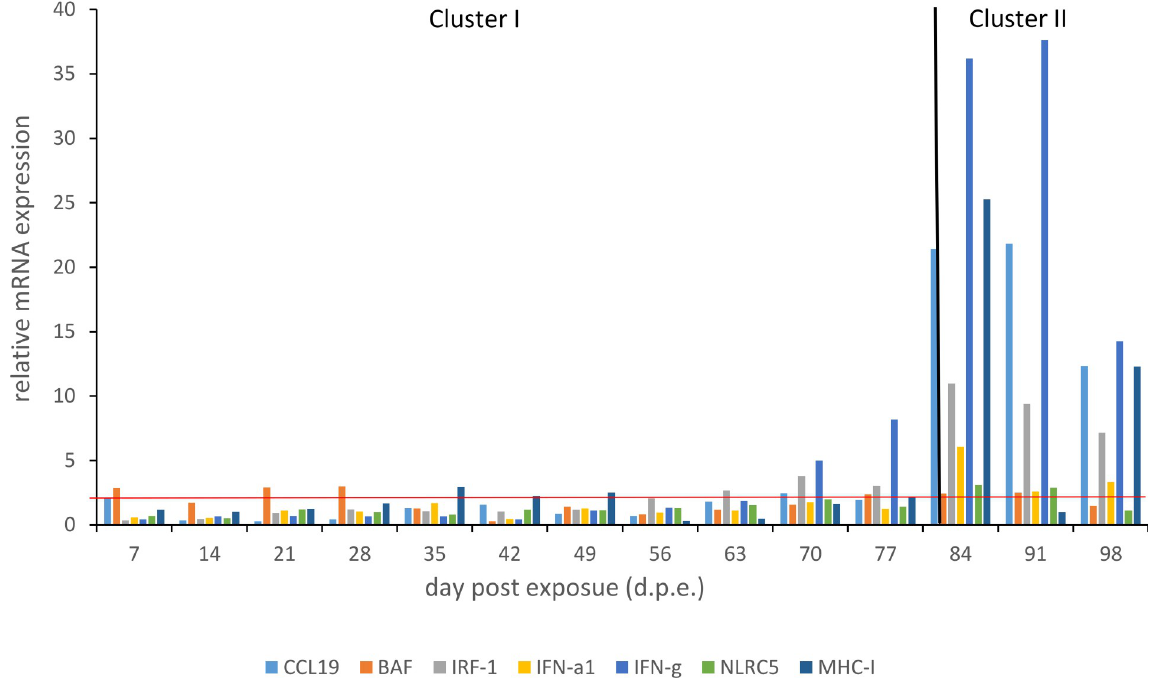
Fig 4. Gene expression profiles over experimental time course (7 to 98 d.p.e.) of genes involved in immune response: Barrier-to- autointegration factor ( BAF ), C-C motif chemokine 19 precursor ( CCL19 ), NOD-like receptor family CARD domain containing 5 ( NLRC5 ), Interferon regulator factor 1 ( IRF-1 ), Interferon alpha 1 ( IFNa1 ), Interferon gamma ( IFN-g ), Major histocompatibility complex I ( MHC-I ); result of the hierarchical clustering analysis based on microarray results (cluster I and cluster II).